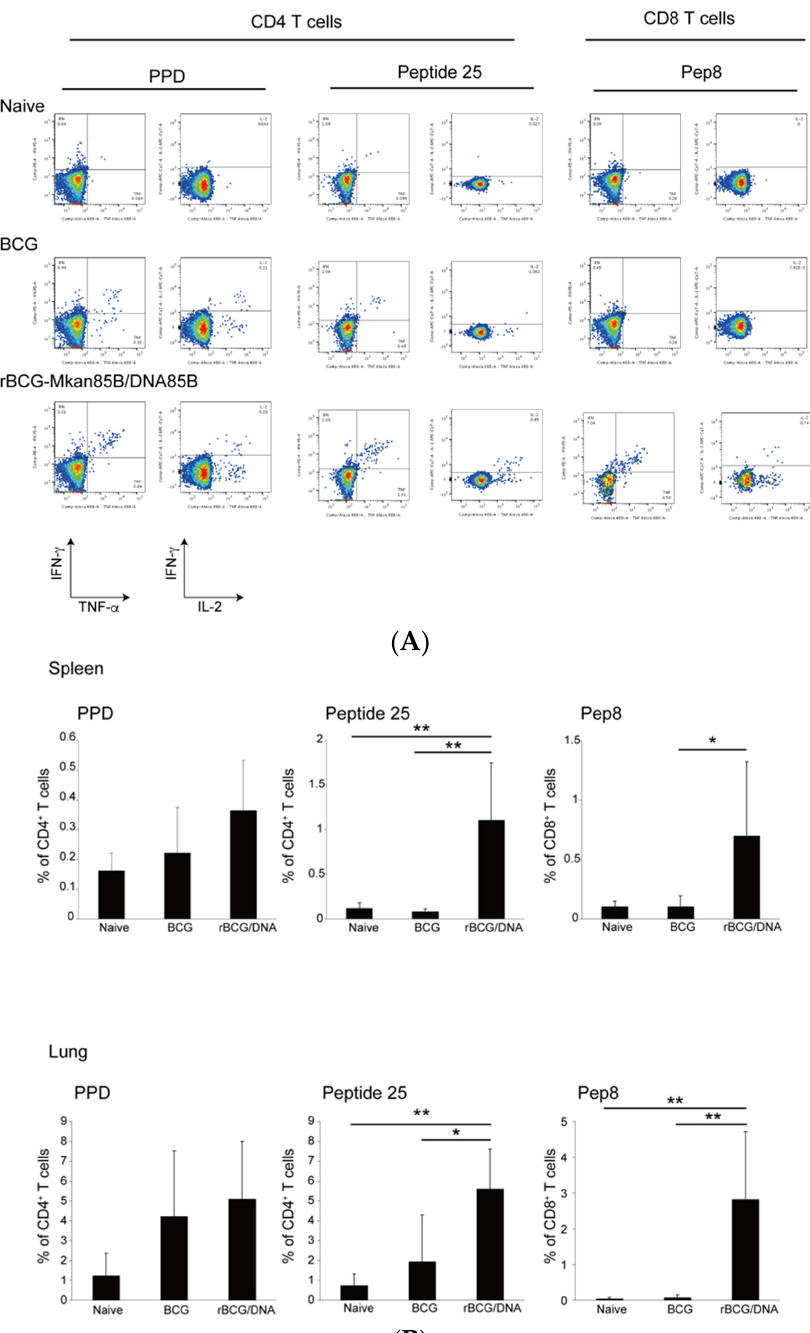
Figure 5. M. kansasii -specific polyfunctional CD4 + and CD8 + T cells in rBCG-Mkan85B/DNA- Mkan85B-prime–boost-vaccinated CB6F1 mice. (A) A representative fluorogram of epitope-specific polyfunctional CD4 + and CD8 + T cell inductions in splenocytes from unvaccinated and vaccinated CB6F1 mice infected with M. kansasii ; TNF is shown on the x -axis and IFN- γ is shown on the y -axis. (B) Polyfunctional CD4 + and CD8 + T cells from the unvaccinated and vaccinated CB6F1 mice infected with M. kansasii . Polyfunctional CD4 + T cell induction by stimulation with PPD (left panel), polyfunctional CD4+ T cell induction by stimulation with peptide 25 (middle panel), and polyfunctional CD8 + T cell induction by stimulation with Pep8 (right panel) in unvaccinated, BCG-, and rBCG-Mkan85B/DNA-Mkan85B-vaccinated mice are shown. The data represent two independent experiments with five to six mice per group. The error bars represent the SD. * p < 0.05. ** p <